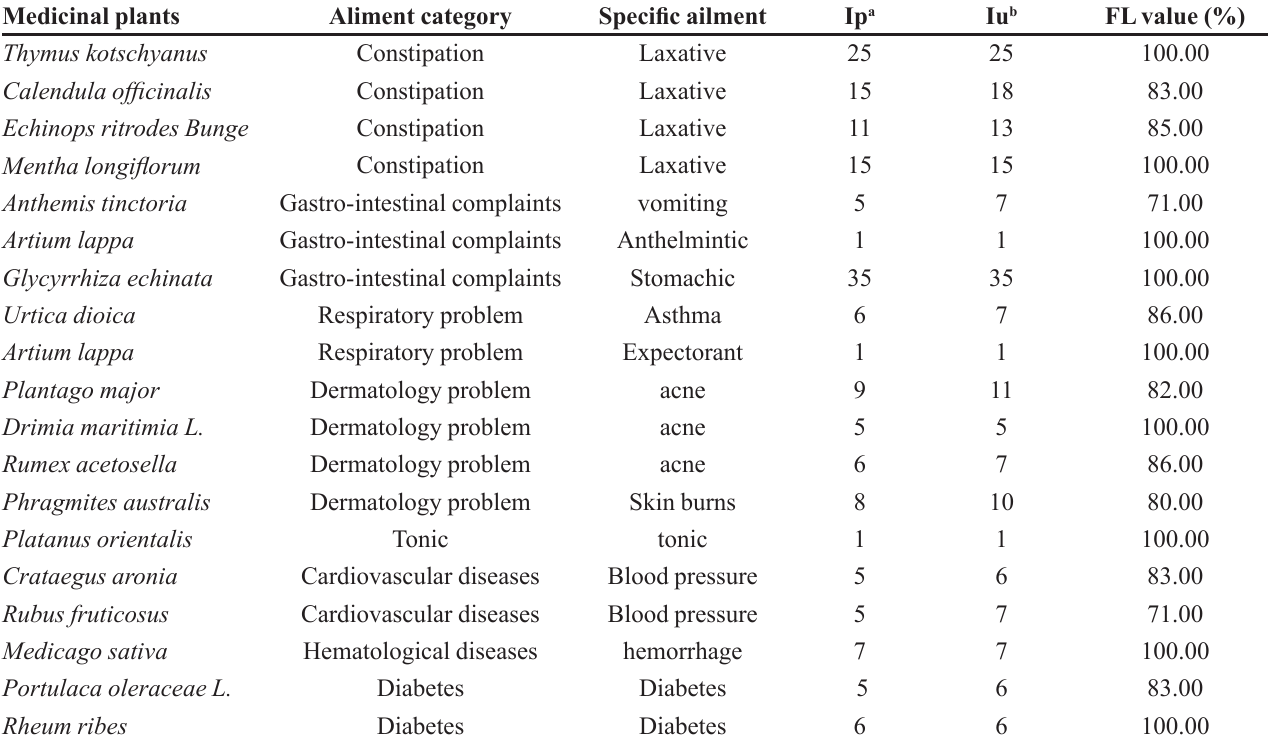
TABLE VII - Fidelity Level (FL) values of medicinal plants Medicinal